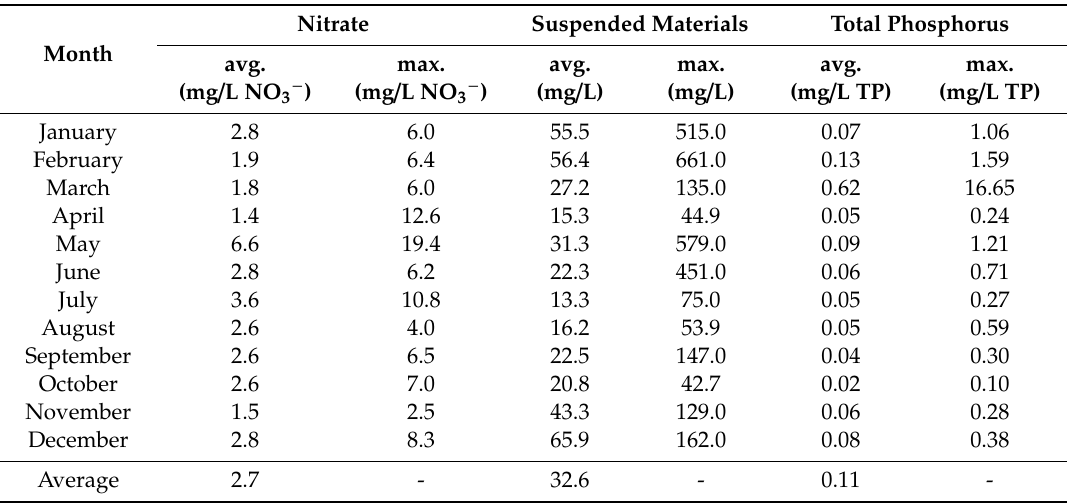
Table 2. Average and maximum monthly levels of nitrate nitrogen, suspended materials, and total phosphorus (TP) (based on daily observations) at the Neblo outflow station on the Kožbanjšˇcek stream from July 2008 to June